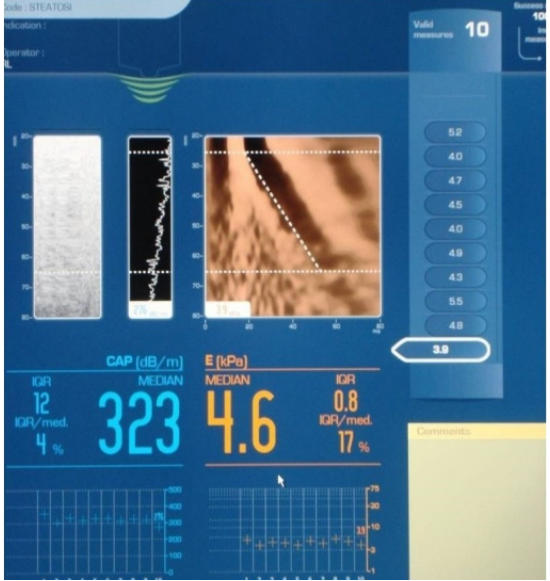
Figure 3. Vibration-controlled transient elastography with controlled attenuation parameter image from the software, a patient acquisition.